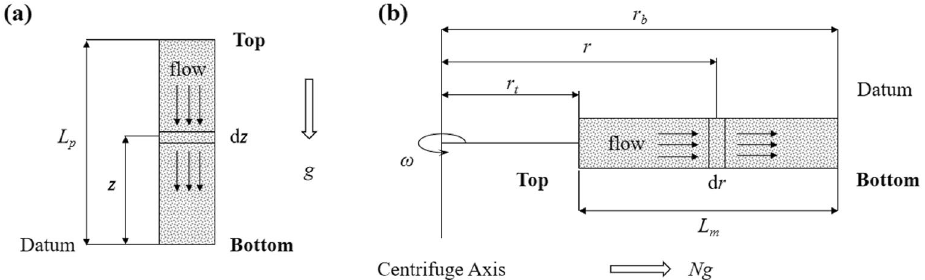
Figure 1. Schematic illustrations of one-dimensional flow taking place in ( a ) natural condition (i.e., prototype) and ( b ) centrifugal model. L p is the length of the prototype, z is the height of current position from column bottom, d z is the infinitesimal increment in z direction, g is the gravitational acceleration, while r t is the model top radius, r b is the model bottom radius, r is the radius of current position, d r is the infinitesimal increment of r , and L m is the length of the centrifugal